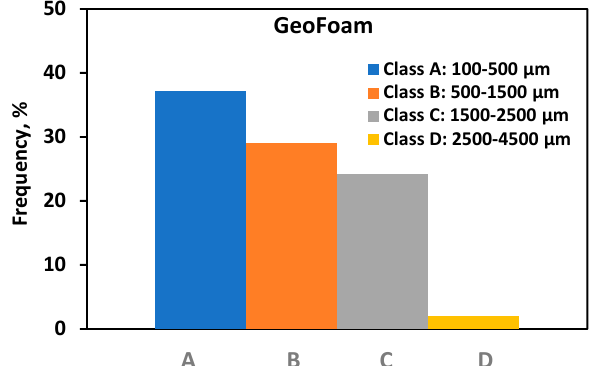
Figure 8. Image J analysis results for frequency % of voids/cm 2 (vertical axis) against the distribution of the void sizes (area—cm 2 ) (horizontal axis) in GeoFoam sample.